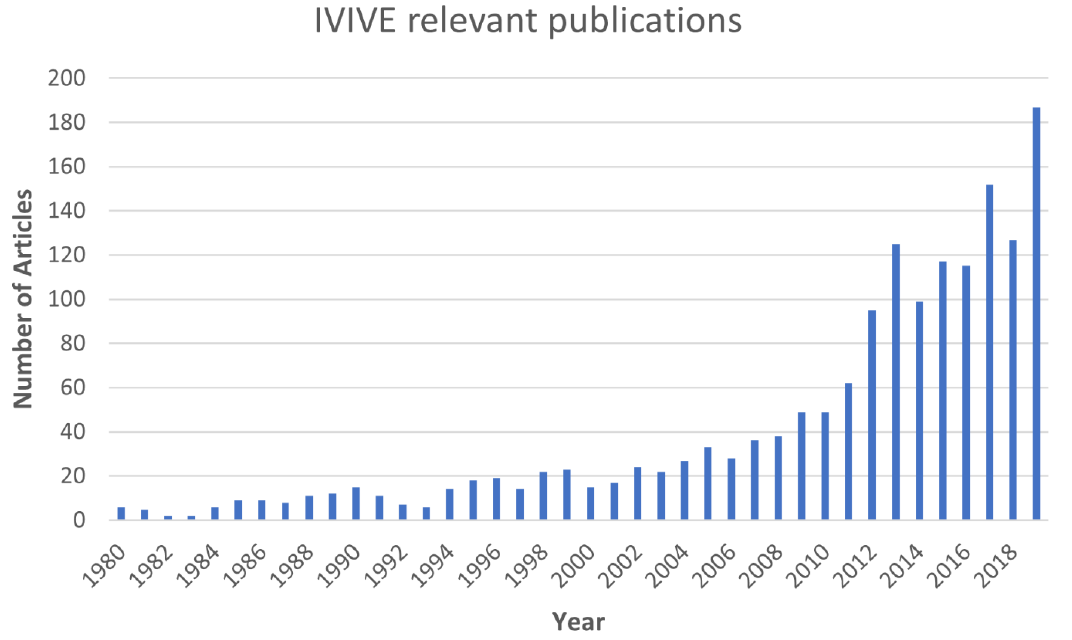
Figure 1. The number of articles found in the literature with the terms “ In vitro to in vivo extrapolation” or “IVIVE”